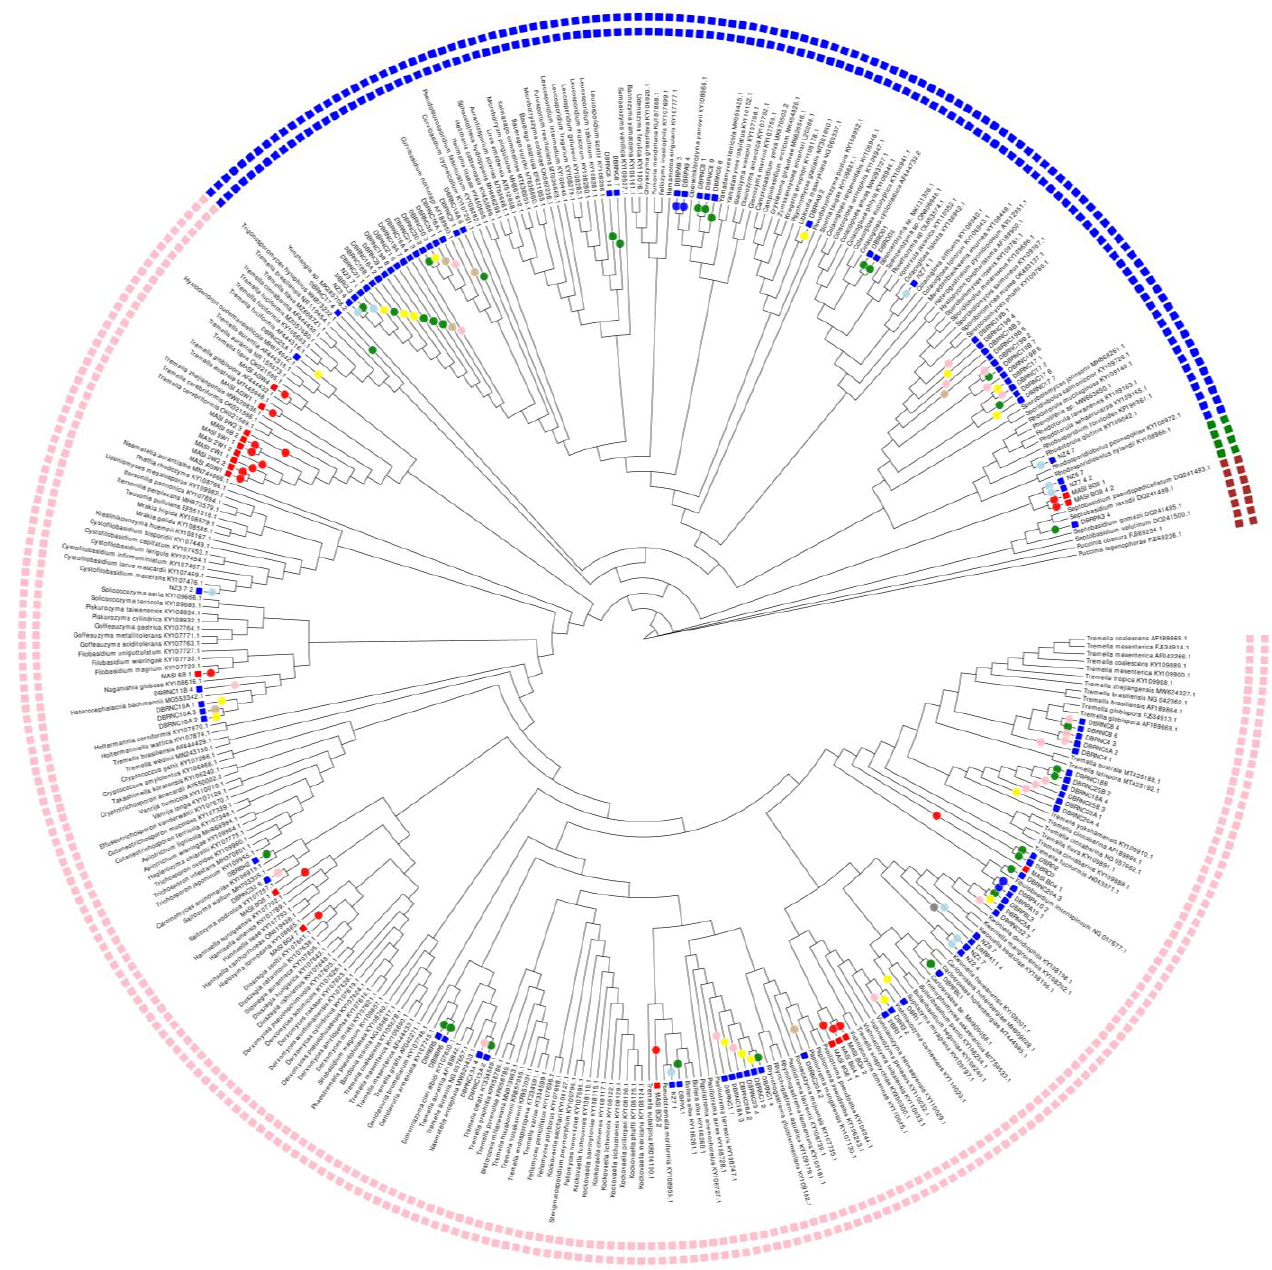
Figure 5. Cladogram of cultured lichen-associated Cystobasidiomycetes, Microbotryomycetes, Puc- ciniomycetes, and Tremellomycetes isolates showing the distribution of isolates obtained across different isolation media. Cladogram reconstructed from LSU alignment, GBLOCK analysis, and PhyML tree reconstruction. Visualization conducted using EvolView 2. Inner blue squares represent isolates obtained via liquid enrichment strategies; inner red squares represent isolates obtained via direct plating methods; taxa with no information are class representative taxa. Branch circles represent isolation medium: red circle = direct plating; green circle = acidified malt broth; tan circle = xerophilic broth; blue circle = monoterpene; pink = nitrogen free; light blue = Nikkomycin Z; yellow = high osmotic broth; grey = saline swab. Outer squares: Pink = Tremellomycetes, Blue = Microbotryomycetes, Green = Cystobasidiomycetes, and red = Pucciniomycetes.